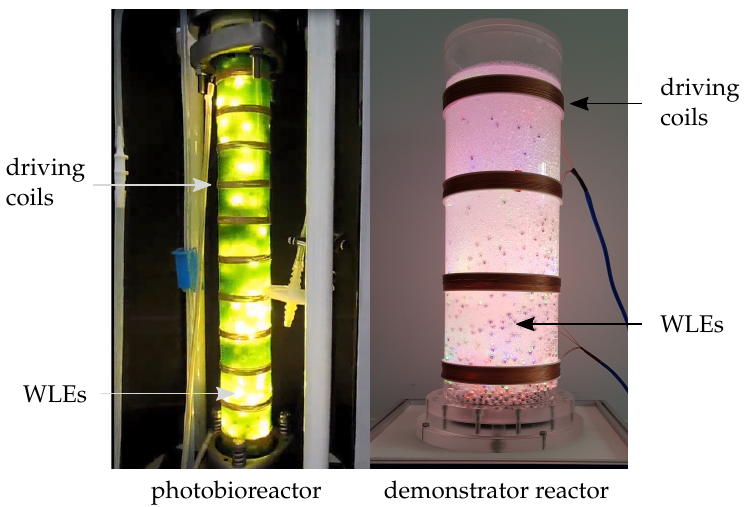
Figure 1. Internal illumination of reactors by means of the WLE based internal illumination system.